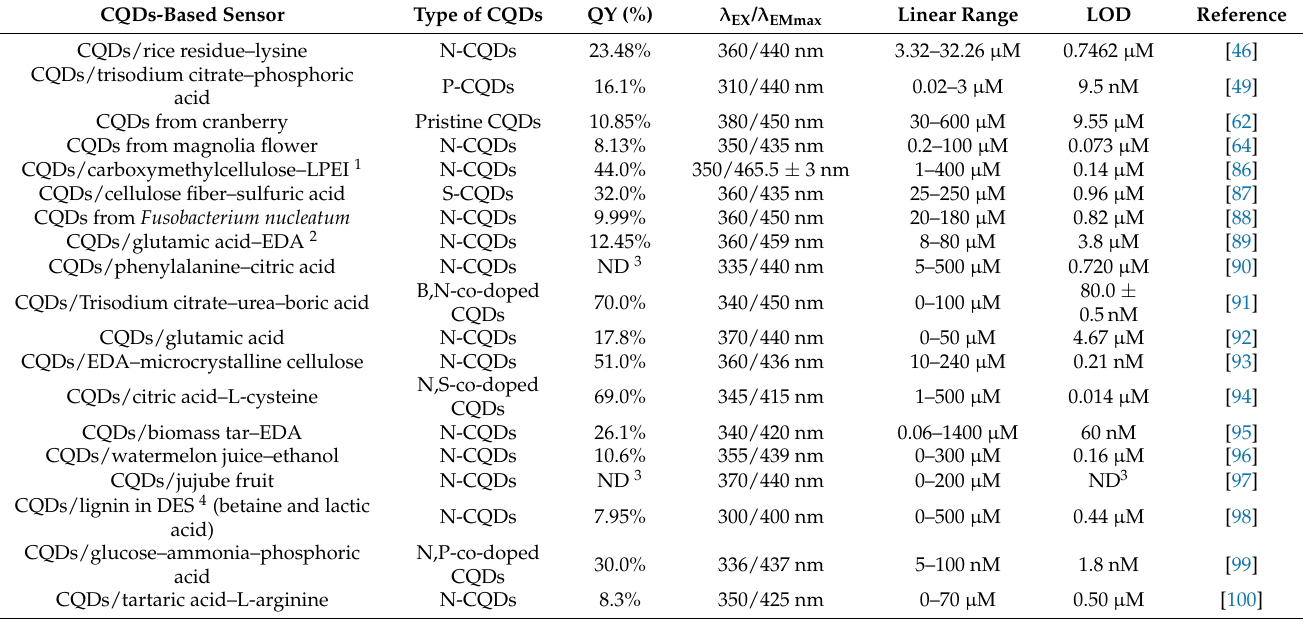
Table 3. Summary of the literature reporting methods of Fe 3+ ions detection of the past five years